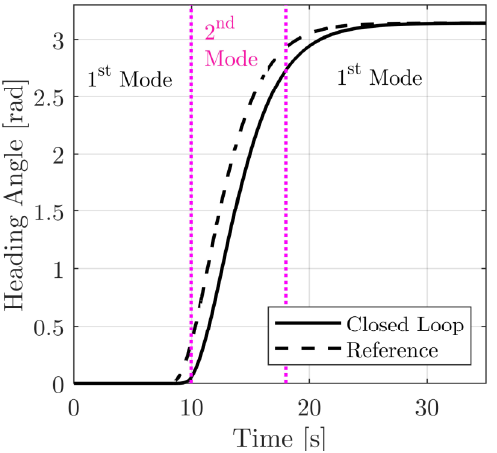
Figure 3. Angular velocity of the vehicle.